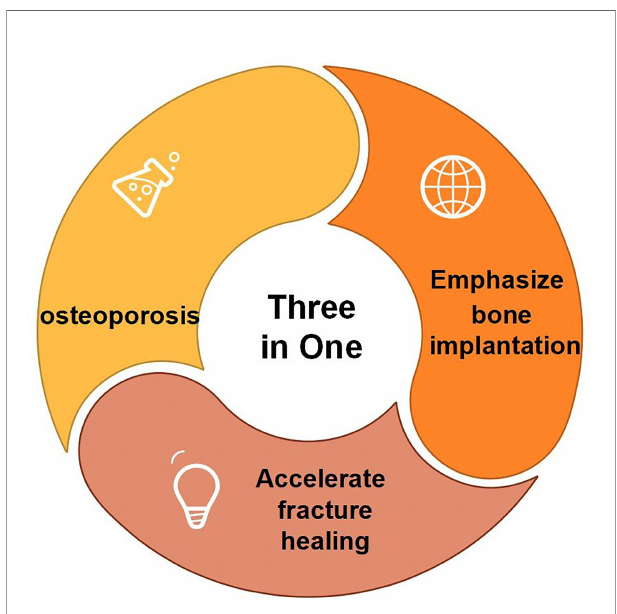
FIGURE 1 | “ Three in One ” bone repair strategy for osteoporotic fractures. The “ Three in one ” strategy consists of anti-osteoporosis, bone implantation and fracture healing